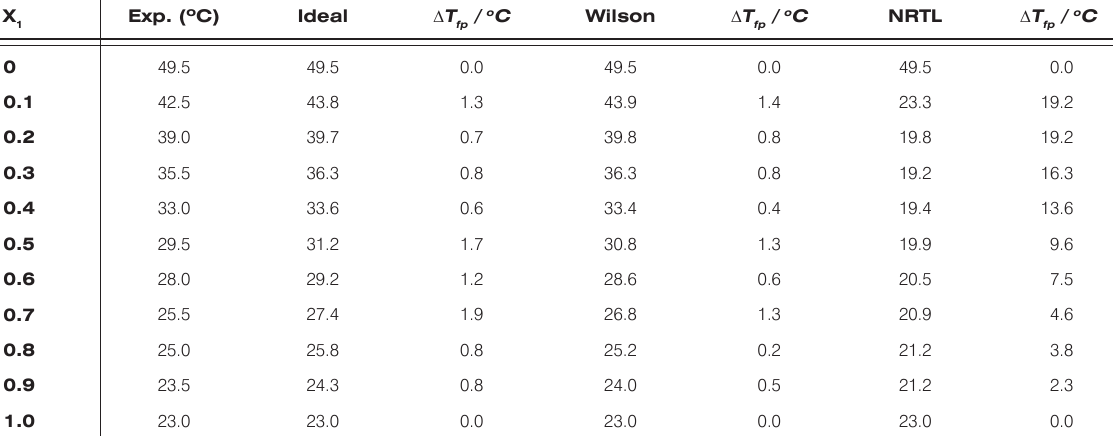
Table 3. Experimental flash points and predictions for 1-propanol (1) + 1-pentanol mixture.